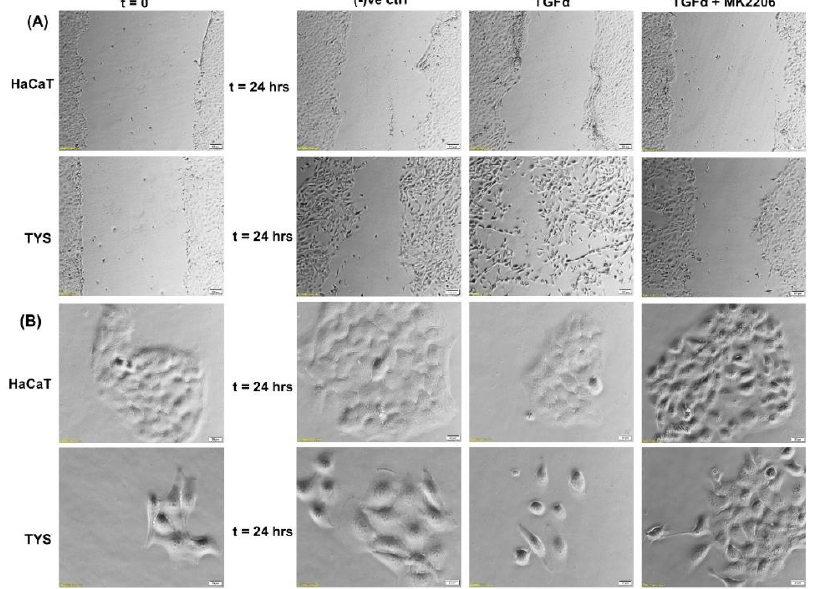
Figure 4. Effect of TGF α on the migration of oral cancer cells. ( A ) A wound was created manually on the cell monolayer and treated with TGF α with or without the inhibitor for 24 h. TGF α stimulated the oral adenoid cancer cells (TYS) to close the gap by migration in the wound healing assay, in comparison to the negative control where little or no migration was observed. The Akt inhibitor, MK2206, effectively blocked TGF α -induced oral cancer cell migration. Normal keratinocytes (HaCaT) were not stimulated to migrate in response to TGF α . Serum-free medium was used as the negative control. Images were captured at t = 0 and at t = 24 h at 50 × magnification. ( B ) Cells were plated at low density to form small colonies of cells for the scatter assay and were then treated with the test conditions for 24 h. TGF α stimulated TYS cells to scatter or migrate away from the compact colonies and a mesenchymal-like morphology of the scattered cells was observed. MK2206 partially blocked TGF α -induced scattering of oral cancer cells. HaCaT did not stimulate cell scattering in response to TGFα. Serum-free medium was used as the negative control. Images were captured at t = 0 and 24 h at 200× magnification. An inverted microscope (Olympus IX70, Tokyo, Japan) with a brightfield camera (SC50) was used to capture the images and CellSense software (Olympus) was used to process the images. The experiments were carried out more than 3 times.